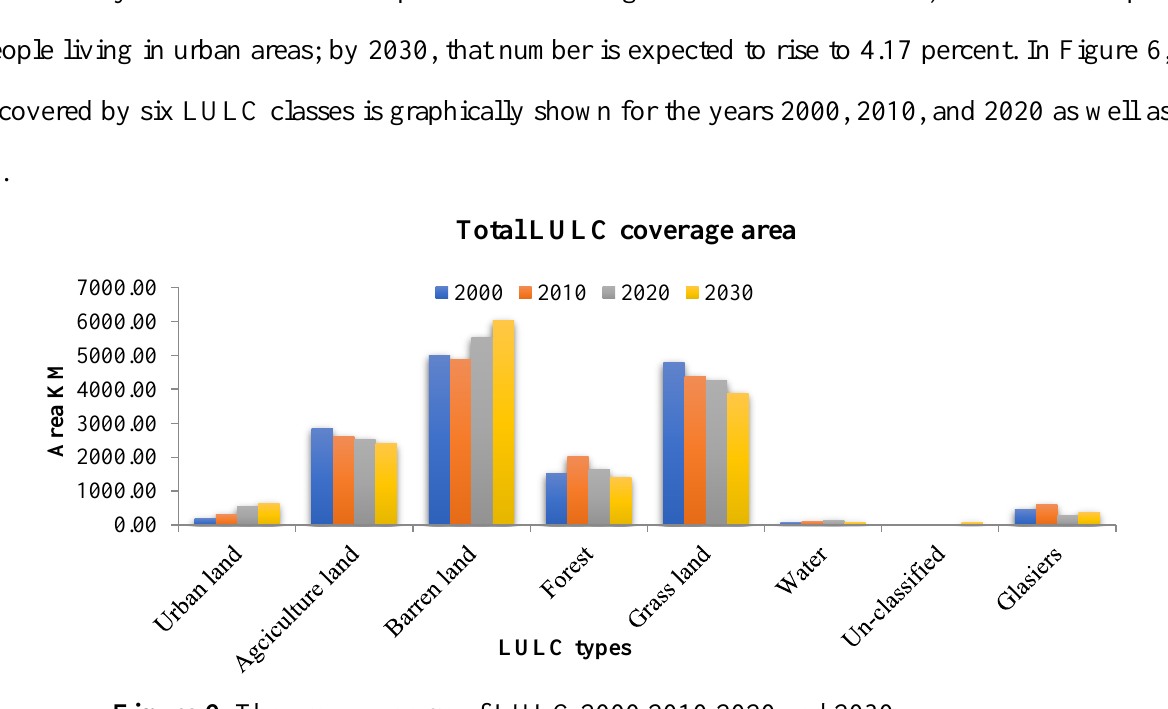
Figure 9. The area coverage of LULC 2000,2010,2020 and